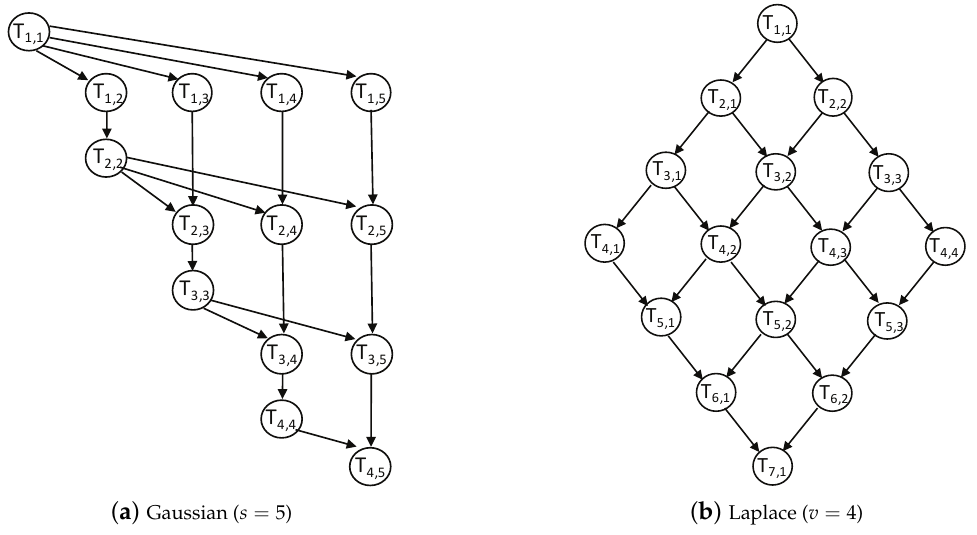
Figure 7. Sample workflow of two real-world applications.